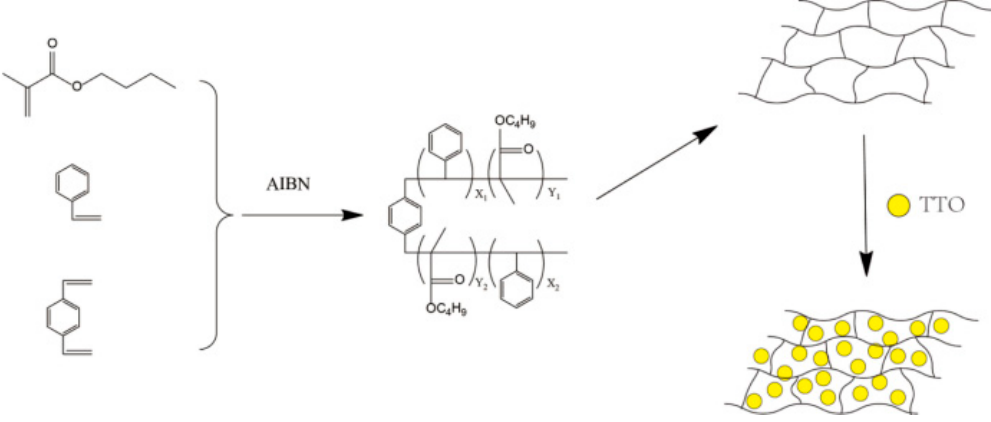
Figure 8. Schematic representation for the synthesis of TTO microspheres.